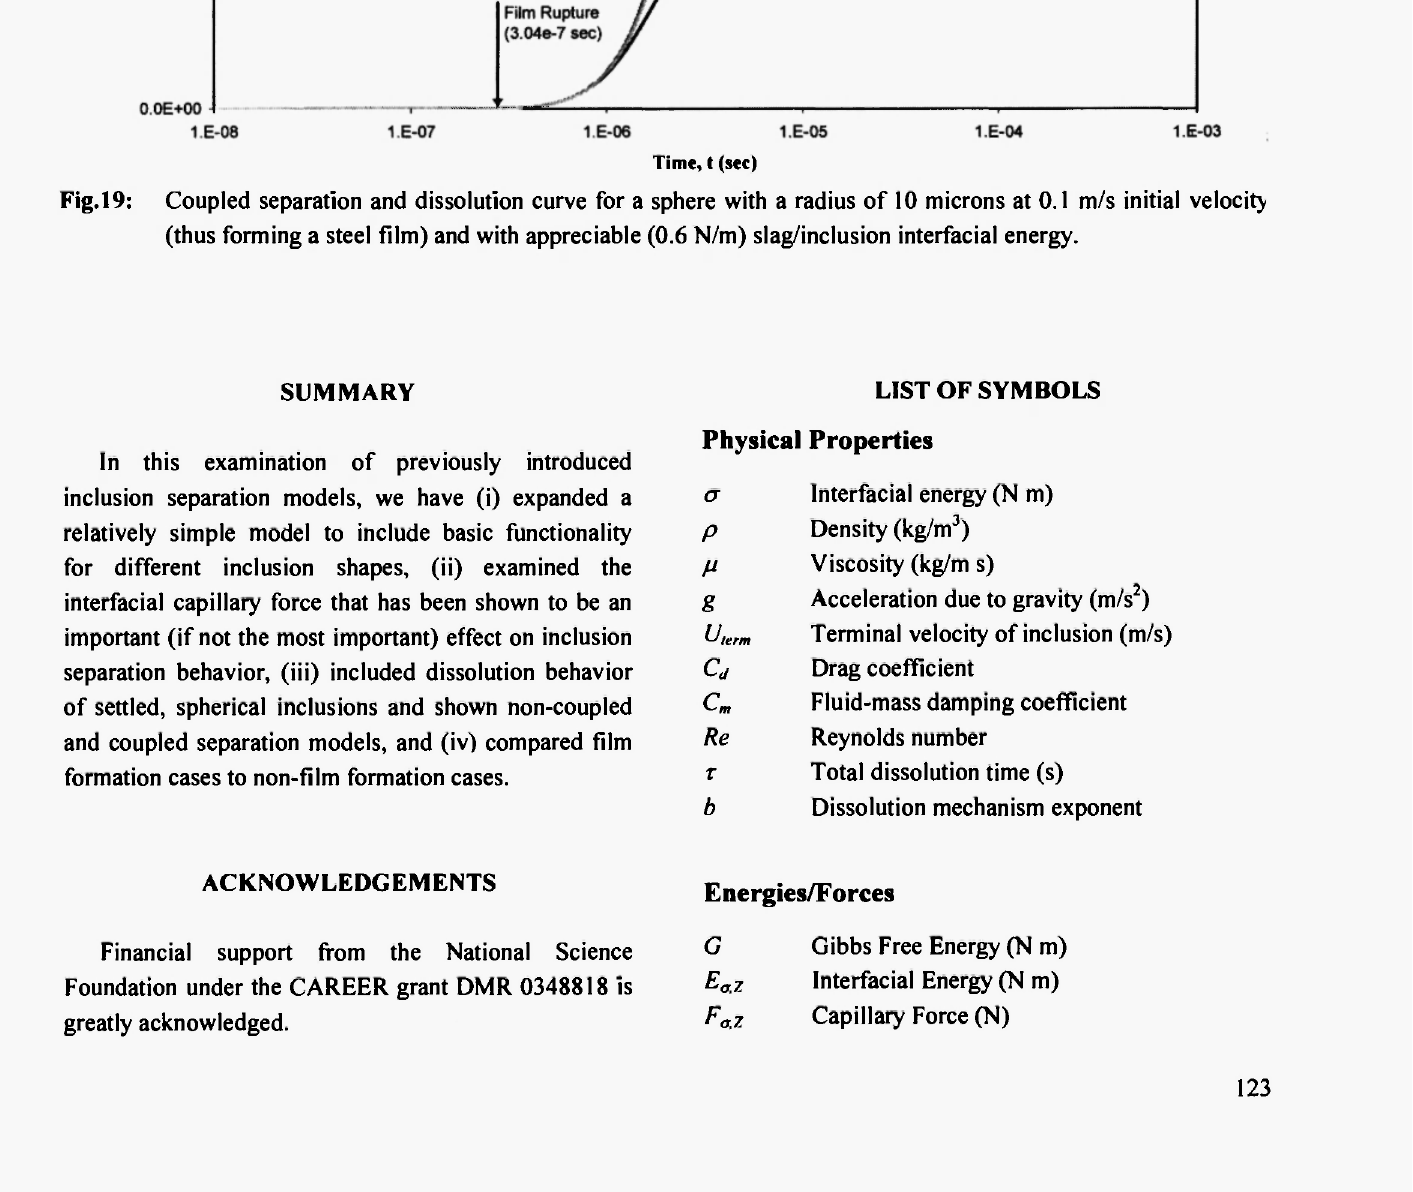
Time, t (sec) Fig.19: Coupled separation and dissolution curve for a sphere with a radius of 10 microns at 0.1 m/s initial velocity (thus forming a steel film) and with appreciable (0.6 N/m) slag/inclusion interfacial